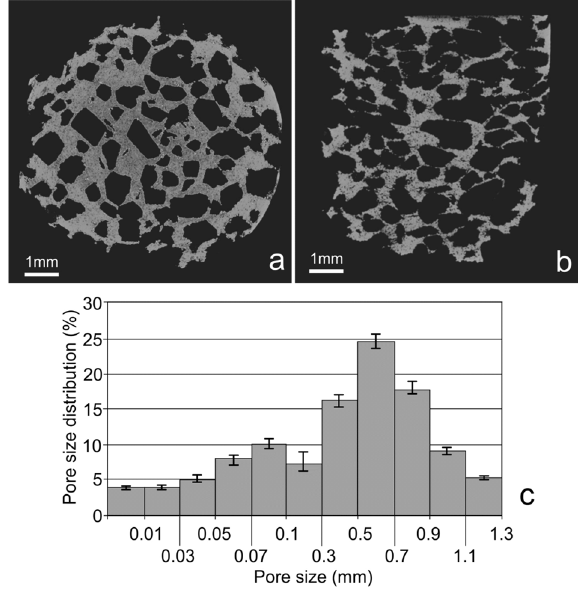
Figure 4. CT cross sections recorded at different sample position—top view ( a ); top-side view ( b ); and calculated pore size distribution ( c